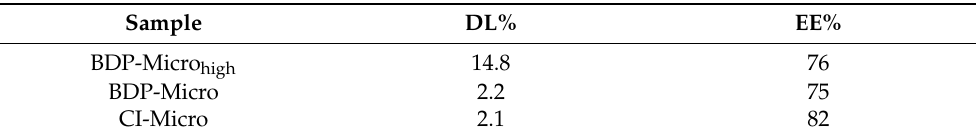
Table 3. DL% and EE% values of the drug-loaded MP